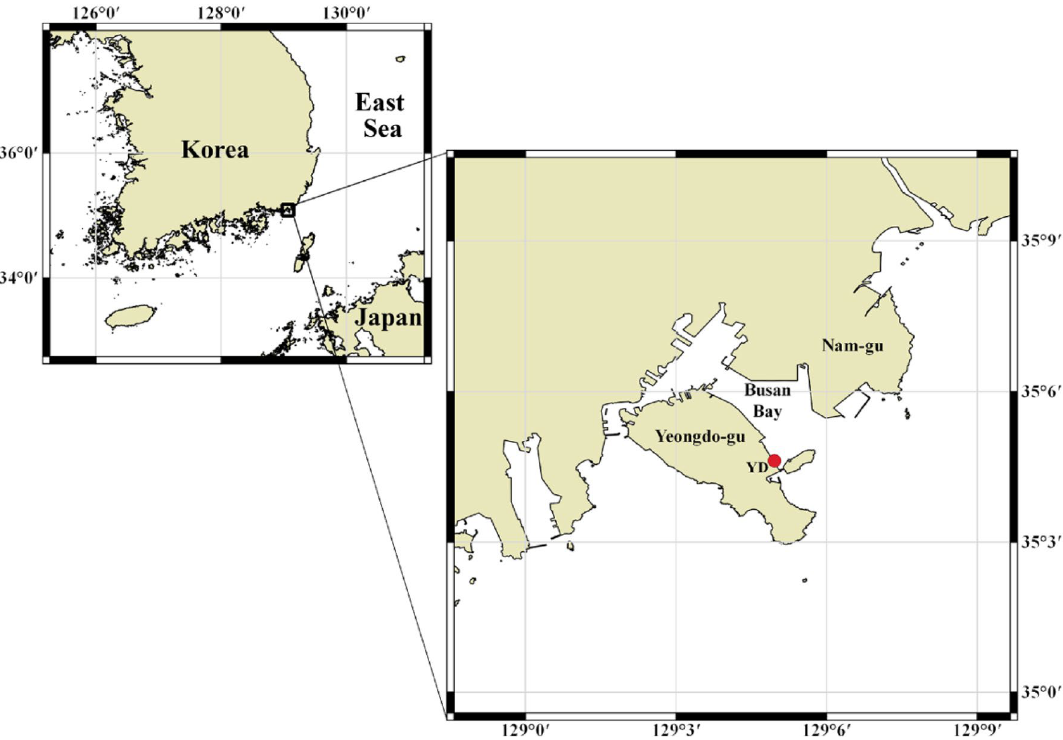
Figure 1. Location of the sampling site (red dot) in Busan Bay, southern coast of Korea. The maps were created using QGIS (v.3.16; www. qgis. org). The base map is from OpenStreetMap and OpenStreetMap Foundation under the Open Database License (https:// www. opens treet map. org/ copyr